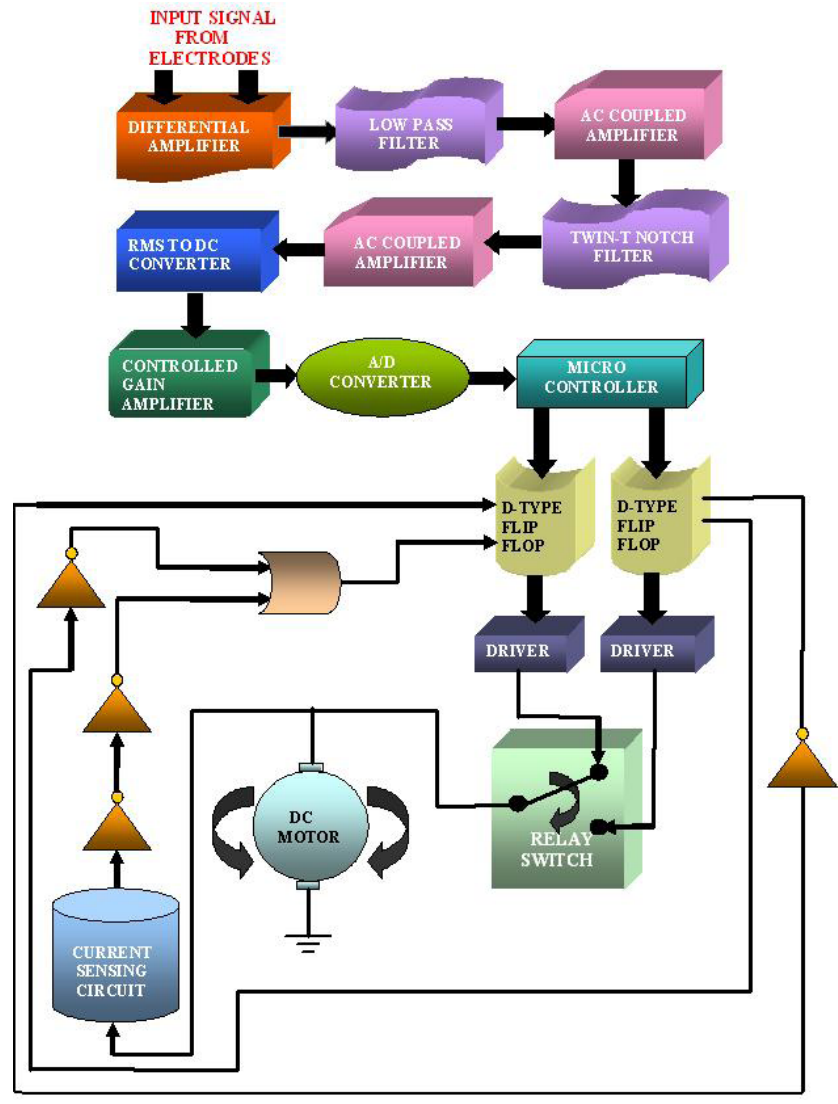
Fig. 1. Block diagram for myoelectric